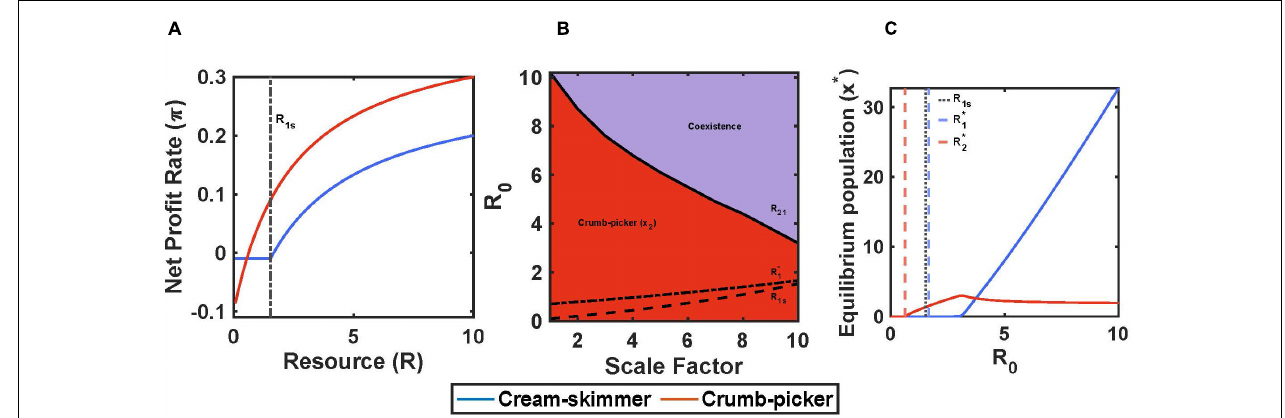
FIGURE 5 | Fixed and total costs trade-off with pulsed resource. (A) The cream-skimmer’s net profit rate has a discontinuity at R 1 s : For R < R 1 s the cream-skimmer is resting, for R > R 1 s the cream-skimmer is active. (B) Regions of competitive exclusion and coexistence change due to initial pulse size R 0 and the scale factor µ . (C) For µ = 10, equilibrium populations change as a function of R 0 . Parameters: µ = 5, f 1 = 0.1–0.009* µ , f 2 = 0.1, c 1 = 0.1+0.01* µ , c 2 = 0.1, b 1 = b 2 = 0.5,